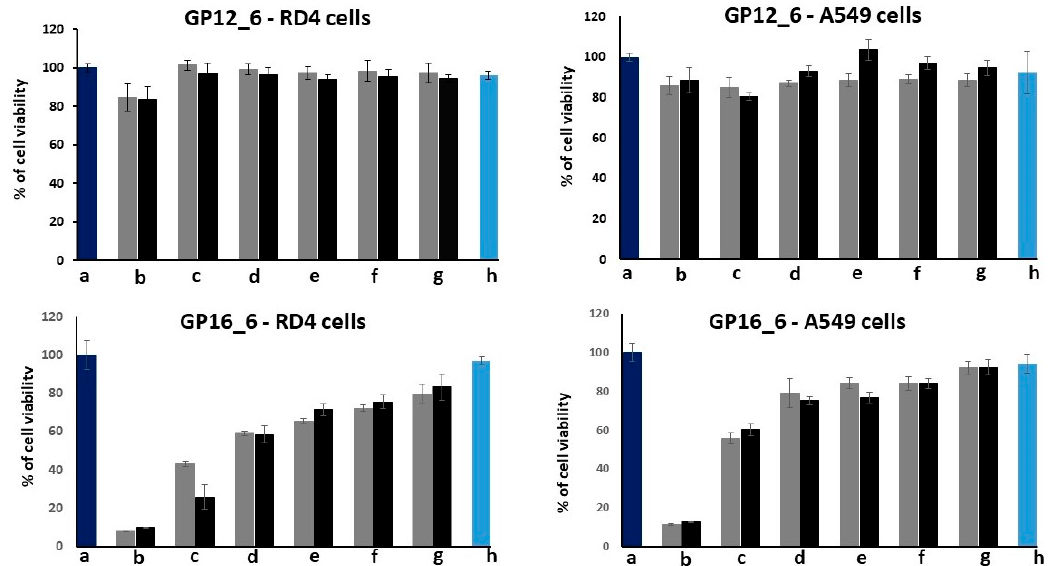
Figure 2. MTT tests on RD4 (left) and A549 cells (right) for GP12_6 (upper) and GP16_6